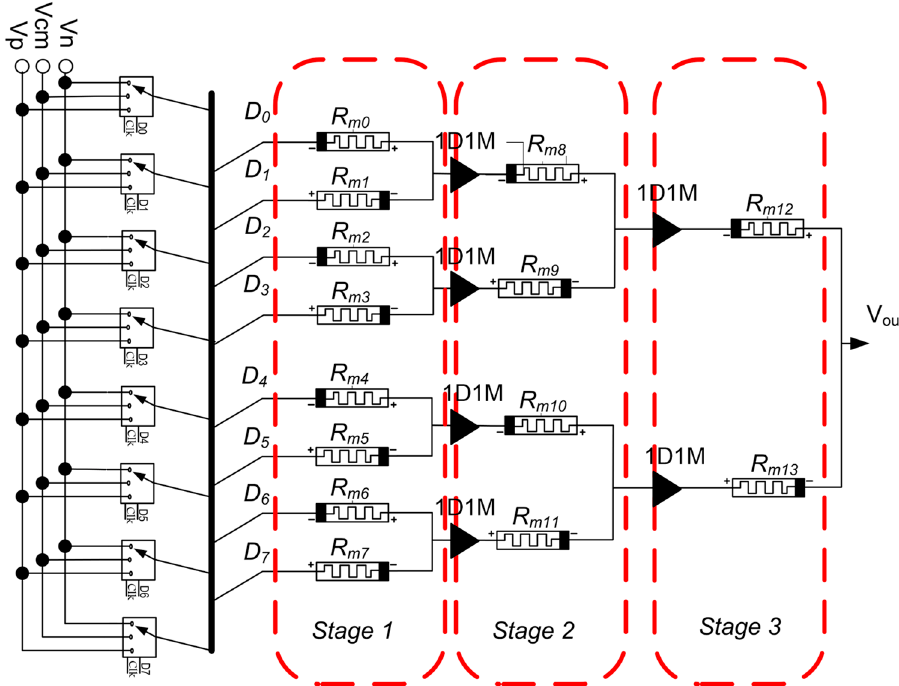
Figure 21. Proposed memristor DAC for the successive approximation register (SAR)-ADC.